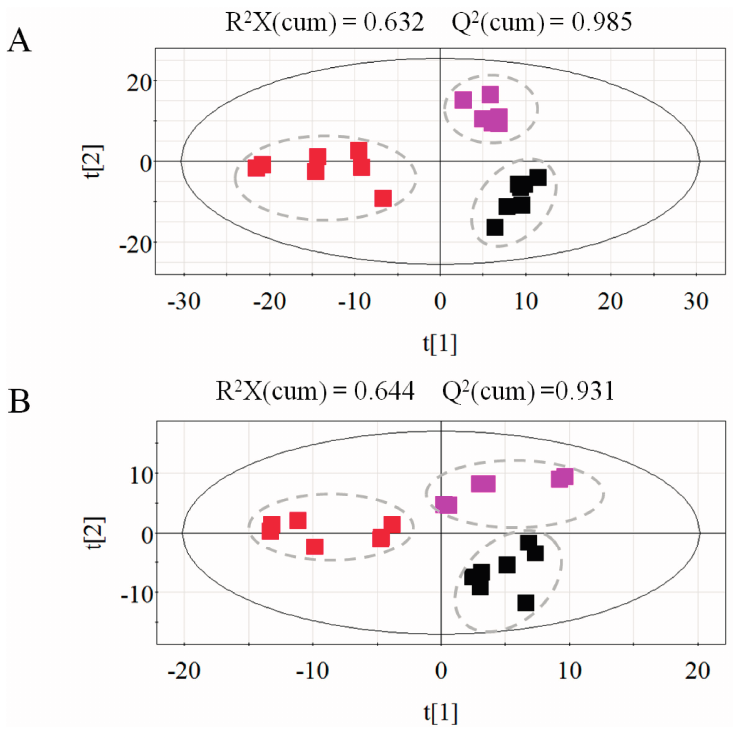
Figure 1. Score plots for the PLS-DA model of the lipophilic ( A ) and polar ( B ) profiles of non-irradiated, 20-Gy-irradiated, and 40-Gy-irradiated samples. The black squares represent the non-irradiated samples, the magenta squares represent the 20-Gy-irradiated samples, and the red squares represent the 40-Gy-irradiated